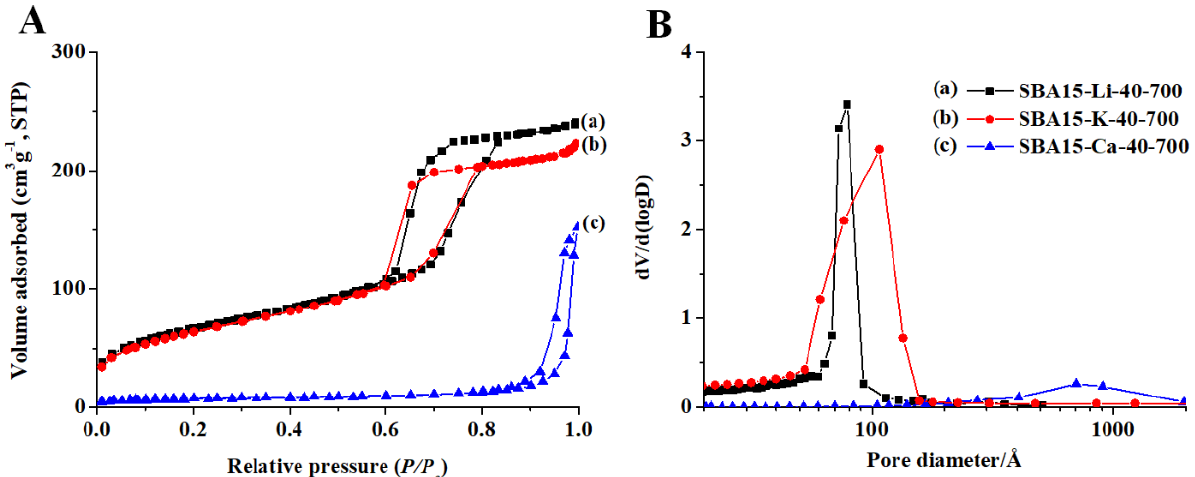
Figure 10. Nitrogen adsorption/desorption isotherm curves ( A ) and pore size distributions ( B ) of (a) SBA15-Li-40-700, (b) SBA15-K-40-700 and (c) SBA15-Ca-40-700 after thermal treatment at 700 ◦ C using different metal ions (Li + , K + and Ca 2+ ) with Si/metal ion = 40. Table 3. Physico-chemical properties of the samples synthesized at 700 °C with Li + , K + and Ca 2+ using Si/metal ion = 40.